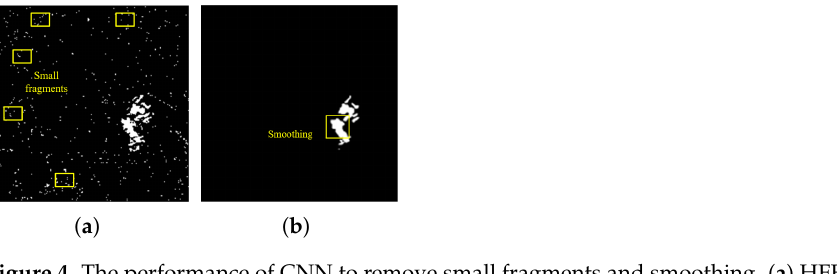
Figure 4. The performance of CNN to remove small fragments and smoothing. ( a ) HFEM threshold- ing result; ( b ) the output of CNN.